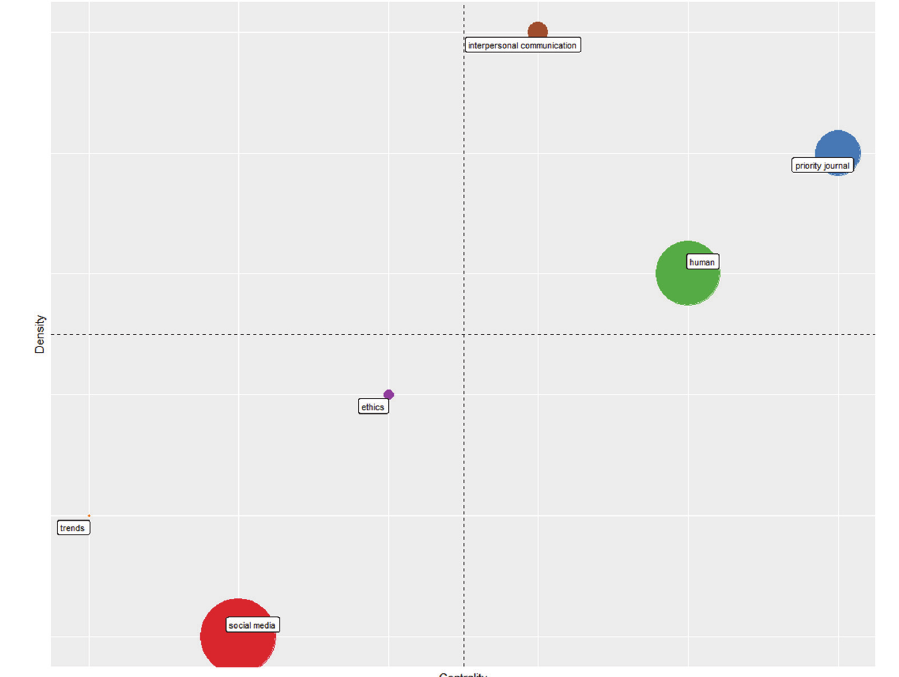
Fig. 12. Thematic